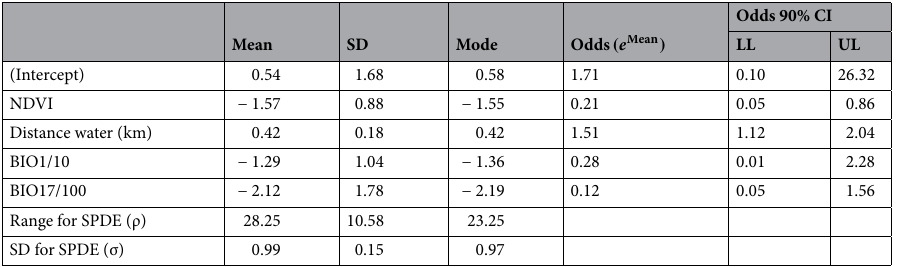
Table 2. Estimated parameters of the fitted hierarchical Bayesian model for the geospatial prediction of human snakebite risk in the Terai. Reporting the posterior marginal mean, standard deviation and mode (logit scale), as well as the corresponding mean, 90% lower- and upper-limit credible intervals (odds scale). The bottom rows report the spatial random effects hyperparameters. Other abbreviations: Stochastic Partial Differential Equations (SPDE).